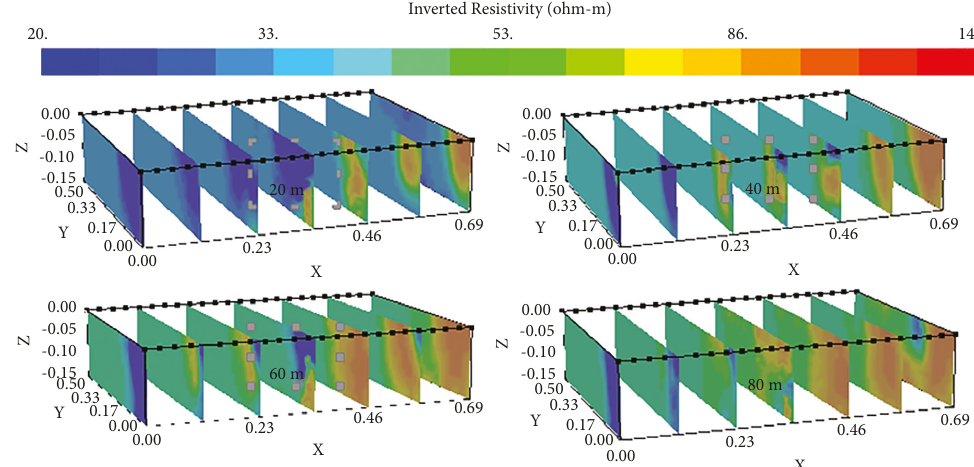
Figure 19: The resistivity section diagram along the x -axis direction at 15 cm above the coal seam.